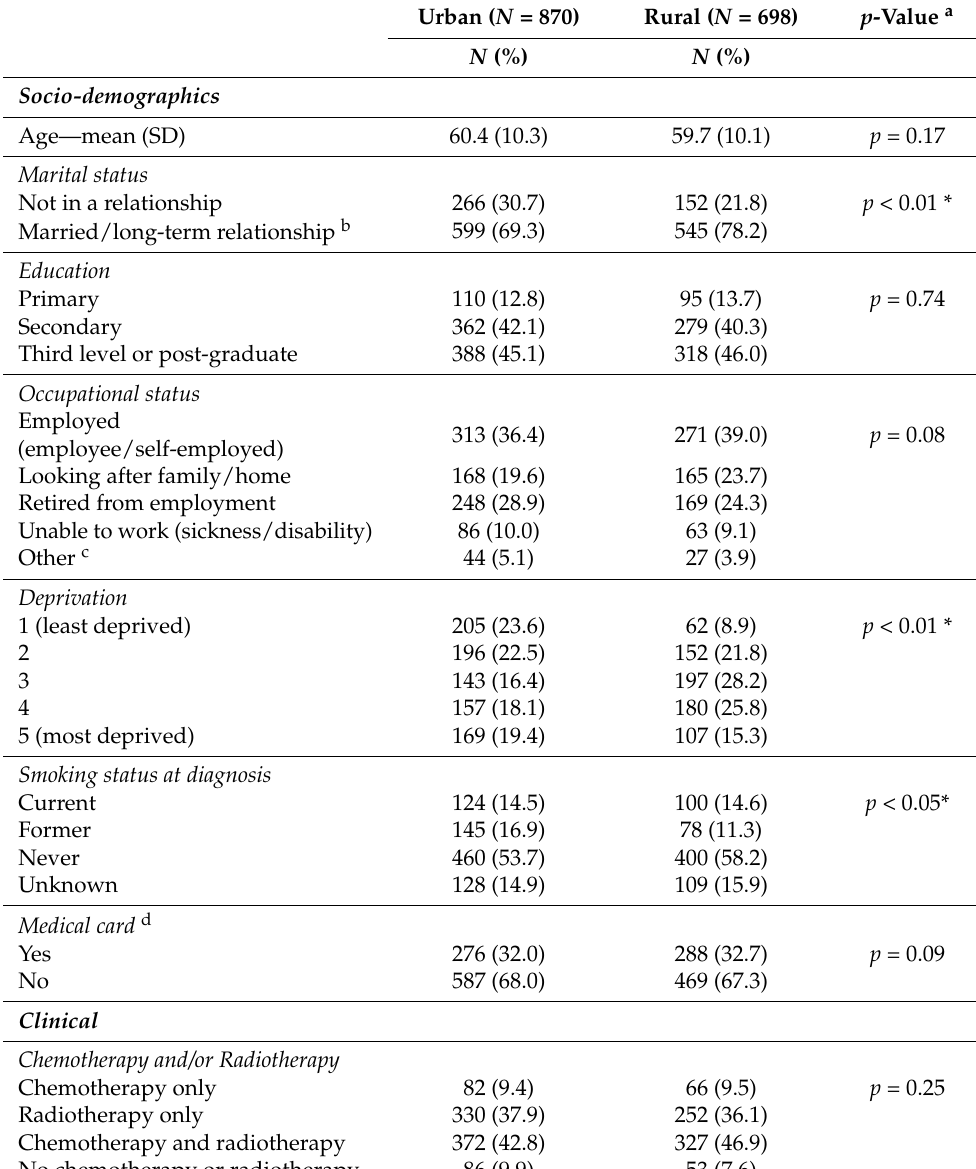
Table 1. Socio-demographic and clinical characteristics of urban and rural survivors of stages I–III breast cancer prescribed endocrine